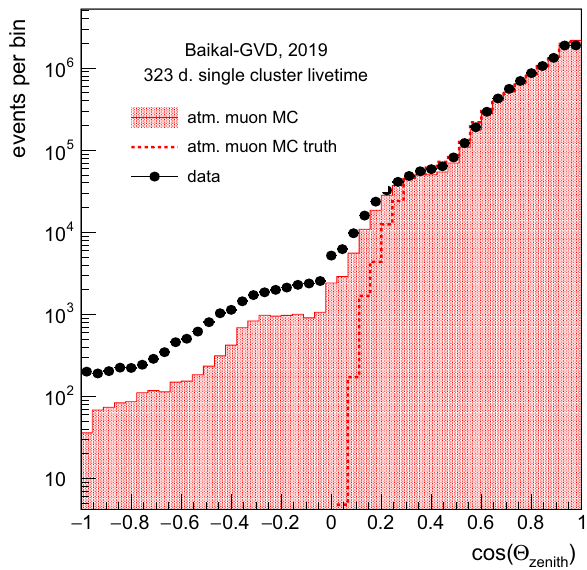
Fig. 2 Zenith angle distribution of reconstructed tracks before quality cuts. The Baikal-GVD 2019 data (five clusters with a combined live- time of 323 days) are shown by black points. The MC prediction for atmospheric muons is shown by red filled histogram. Additionally, the distribution of the true zenith angle of the MC events is shown (dashed red line)